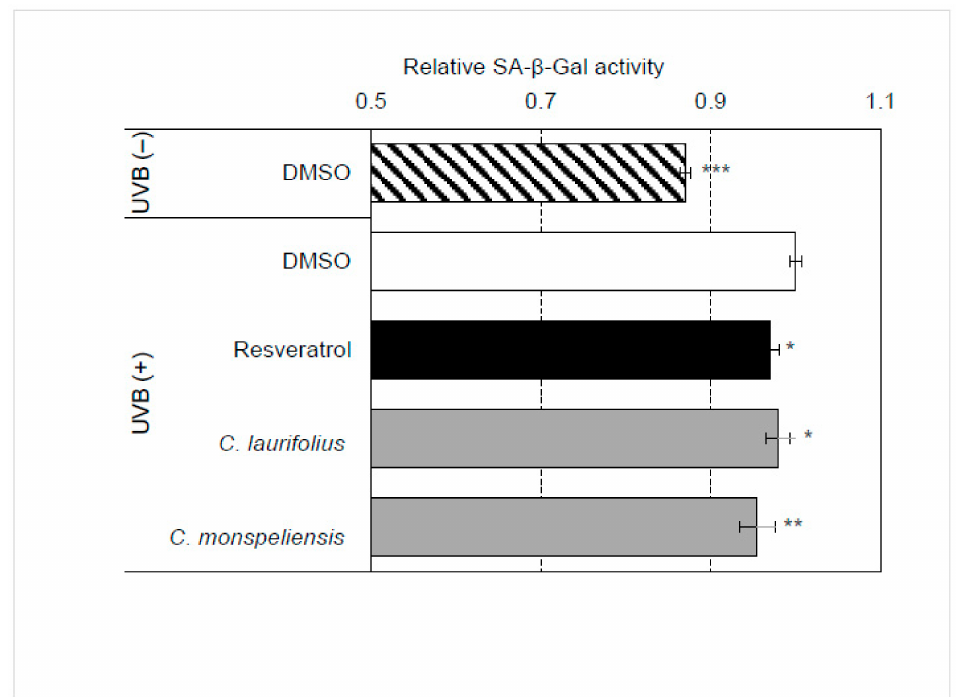
Figure 6. Effects of essential oils on UVB-induced cellular senescence. HaCaT cells were irradiated with 10 mJ/cm 2 and then treated with essential oils (final concentration: 100 ng/mL) for 48 h. The effects of essential oils on the UVB-induced cellular senescence were evaluated by using a fluorescent substrate of β -galactosidase, C12FDG. Statistical significance was determined by using a two-sided Student’s t -test. Statistical significance was evaluated by comparison with the control irradiated with UVB and defined as p < 0.05 (* p < 0.05; ** p < 0.01; *** p < 0.001). Values are means ± SEM ( n =